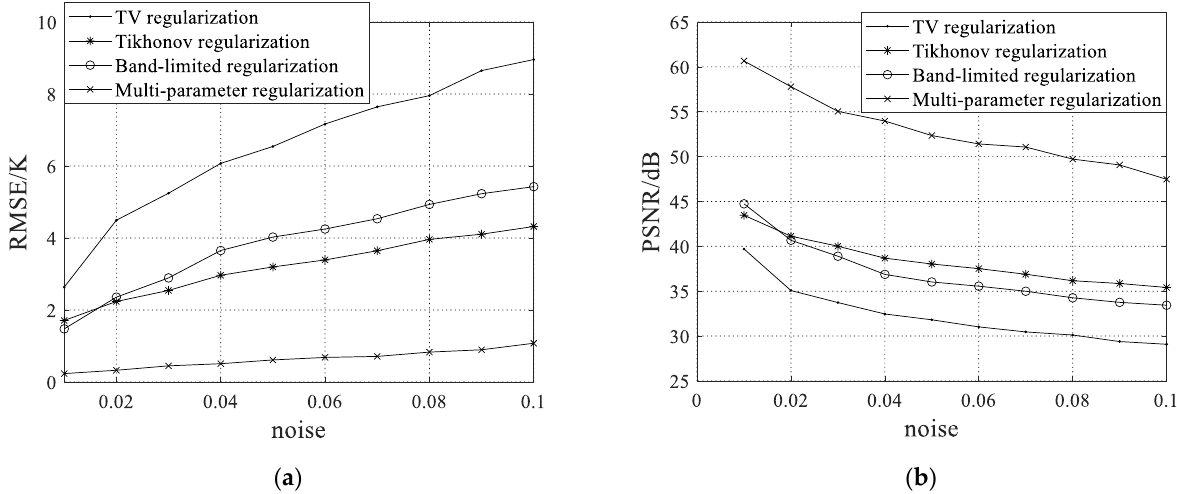
Figure 5. The performance of the regularization methods for the ocean for different noise levels: ( a ) the root mean square error; ( b ) the peak signal to noise ratio.